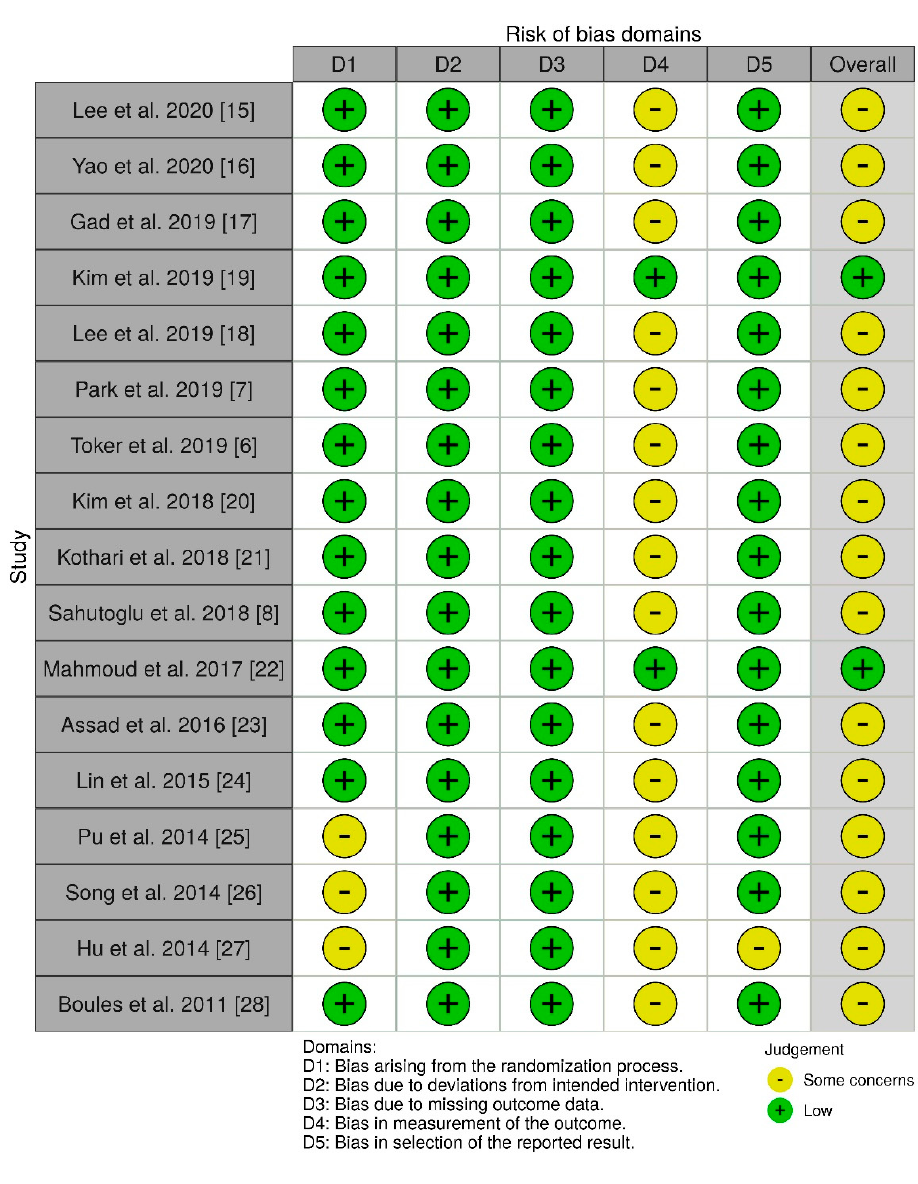
Figure 2. Risk of bias traffic light plot.